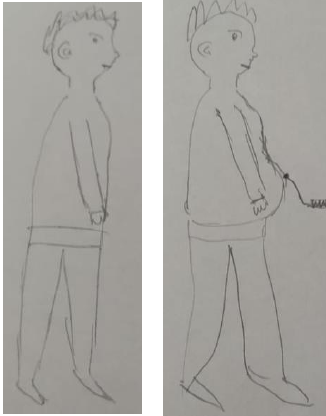
Figure 1. Self-figure drawing drawn by a 67-year-old male undergoing peritoneal dialysis: pre-diagnosis vs. at present.